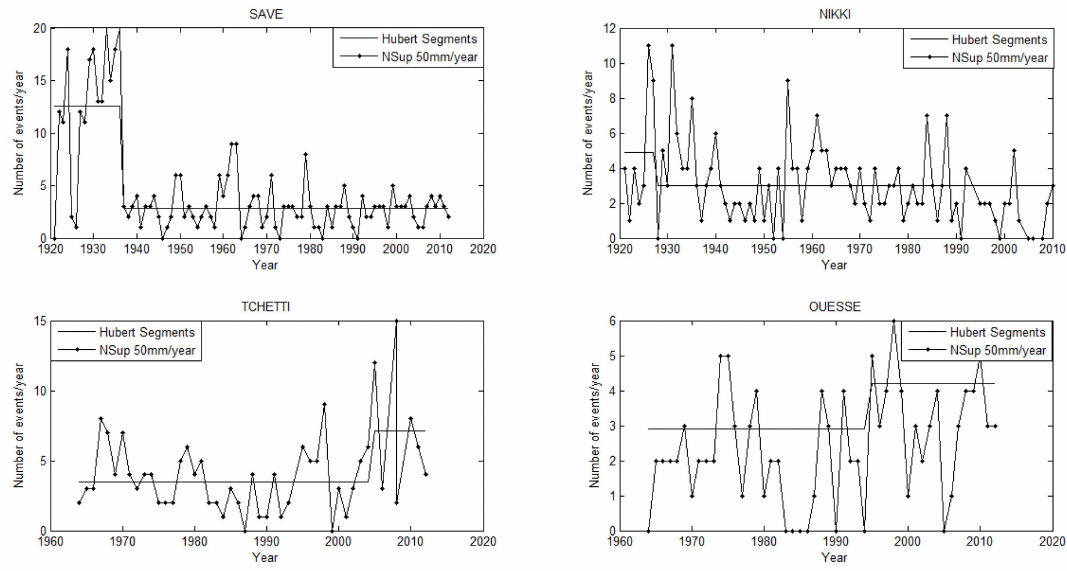
Figure 5. Number of heavy rainfall days per year with Hubert segmentation for four stations showing highest changes (negative (Savè and Nikki) and positive (Ouèssè and Tchètti)) at a threshold of 50